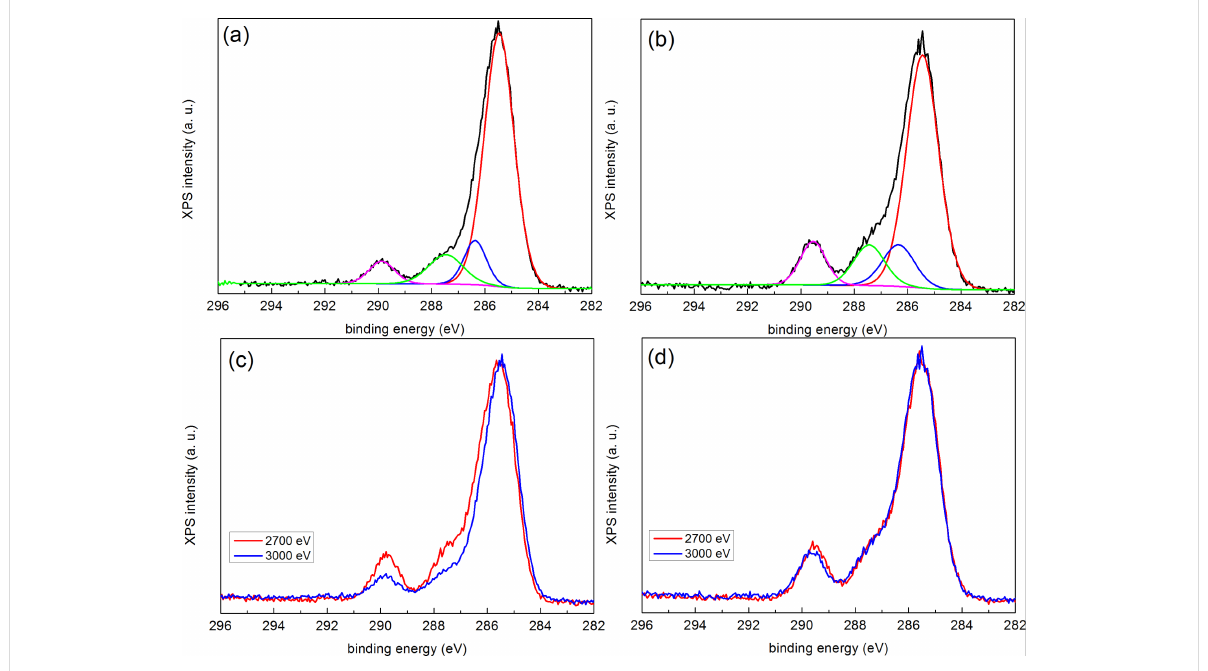
Figure 5: HAXPES spectra corresponding to the C 1s region of (a) unmodified and (b) modified samples, respectively, taken with 3000 eV photons in- cluding a deconvolution of the components using a least-square fit after background subtraction. Comparison of spectra taken with 2700 and 3000 eV photons of the unmodified (c) and modified (d) samples, respectively. Spectra in (c) and (d) have been normalized and aligned to the peak